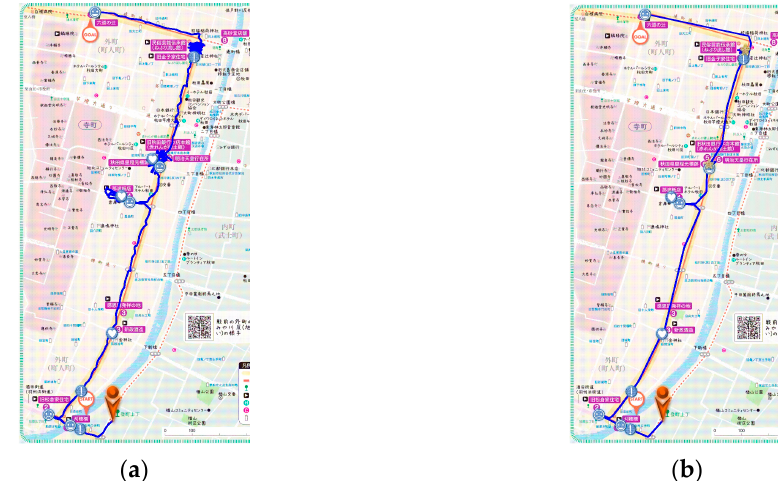
Figure 12. ( a ) Raw trajectory mapping, ( b ) articulated trajectory mapping (blue line: trajectory; blue round label with emoji: point of UGC, e.g., photos and textual notes; star label: point of staying).